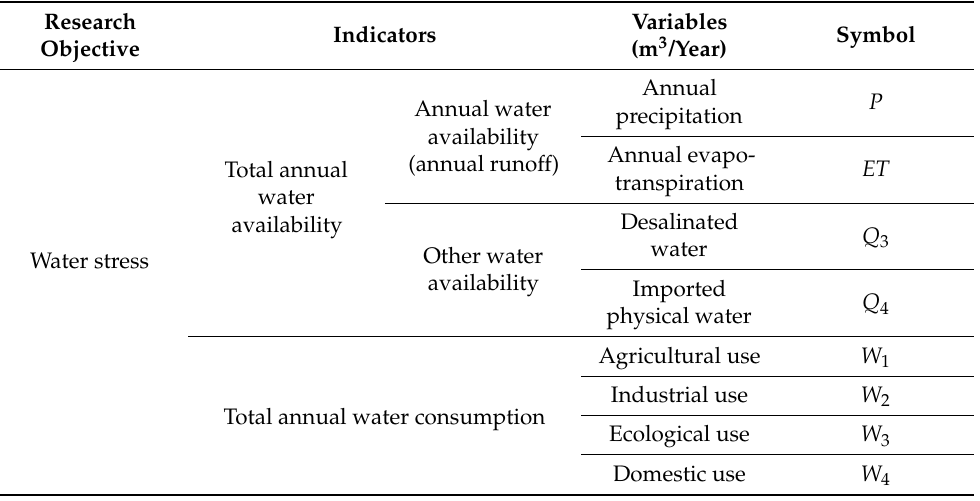
Table 1. Indicators to assess water stress without virtual water